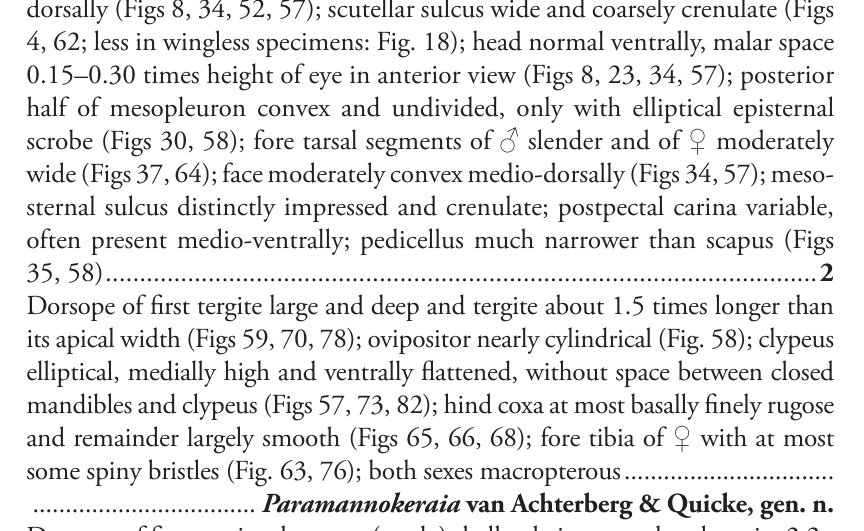
Mannokeraia van Achterberg, 1995: 96–97. Type species. Mannokeraia aptera van Achterberg, 1995 (examined). Diagnosis. Antenna of ♀ with 16–20 segments, and segments of apical half mon- iliform (Figs 11, 19, 38), of ♂ with 31–32 segments and segments much longer than wide (Figs 12, 44); clypeus strongly transverse and with steep ventral face, usually with transverse space between clypeus and closed mandibles (Figs 34, 52); absent in M. aptera : Fig. 23); head transverse and enlarged behind eyes (Figs 9, 17, 35, 43, 53); pronotal collar reaching level of mesoscutum in wingless females (Fig. 19), but much lower in macropterous specimens (Figs 3, 47); notauli reduced or united posteriorly (Figs 31, 41, 48); mesosternal sulcus distinct and crenulate; postpectal carina distinct medio-ventrally (but not visible in M. aptera ); fore tibia of ♀ with distinct spines; hind coxa completely rugose; hind tibia densely striated; tarsal claws with a rounded lobe; dorsope of first tergite absent (at most weakly developed in M. albipalpis ), 2.2–2.9 times longer than its apical width and tergite weakly widened posteriorly (Figs 5,